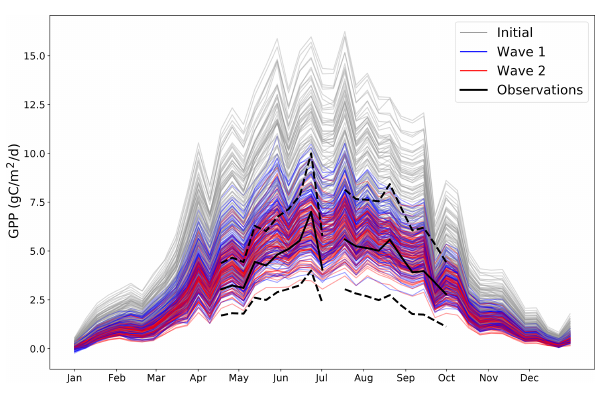
Figure 4. Different time series of GPP for the year 2002 for a ran- domly chosen coordinate where we have observations. Grey lines represent 100 randomly chosen parameter settings before any tun- ing is performed. Blue lines represent 100 randomly chosen param- eter settings after the first wave of tuning. Red lines represent 100 randomly chosen parameter settings after the second wave of tun- ing. The black solid line represents the observations for that coordi- nate (and the black dashed lines represent the 2 standard deviation intervals of the observational error). By its nature, all possible wave 2 trajectories must be a subset of all possible wave 1 trajectories, which in turn must also be a subset of all possible initial trajecto-